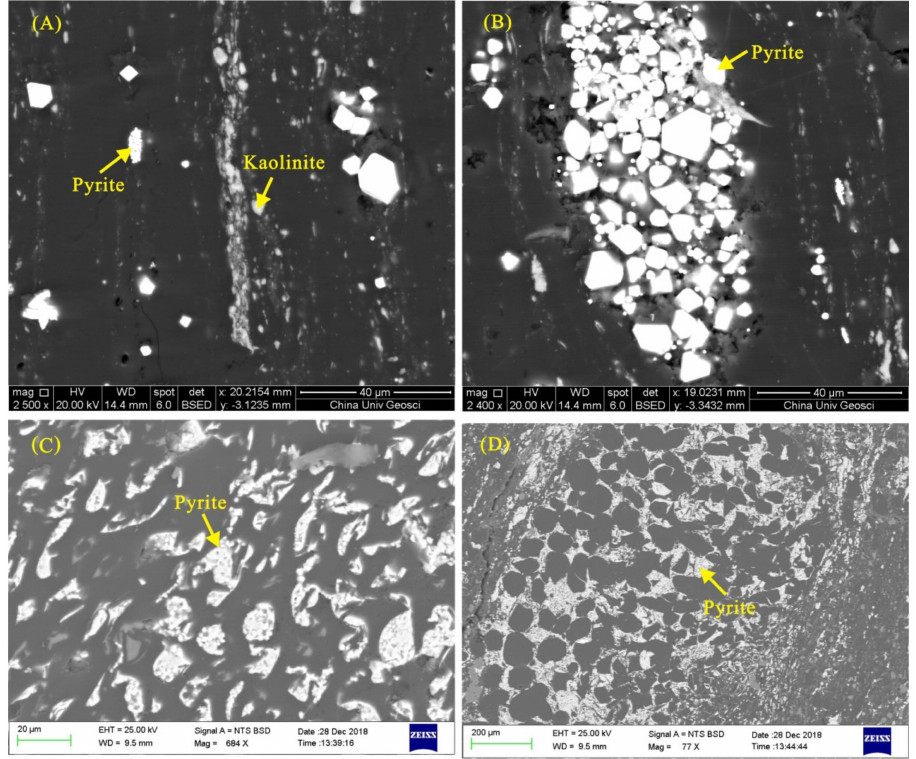
Figure 6. Scanning electron microscope (SEM) back-scattered electron images of minerals in the C4 Coal. ( A ): isolated pyrite and kaolinite grains (sample CLB4-12); ( B ): euhedral pyrite aggregate (sample CLB4-12); ( C ) and ( D ): cell-filling pyrite (sample